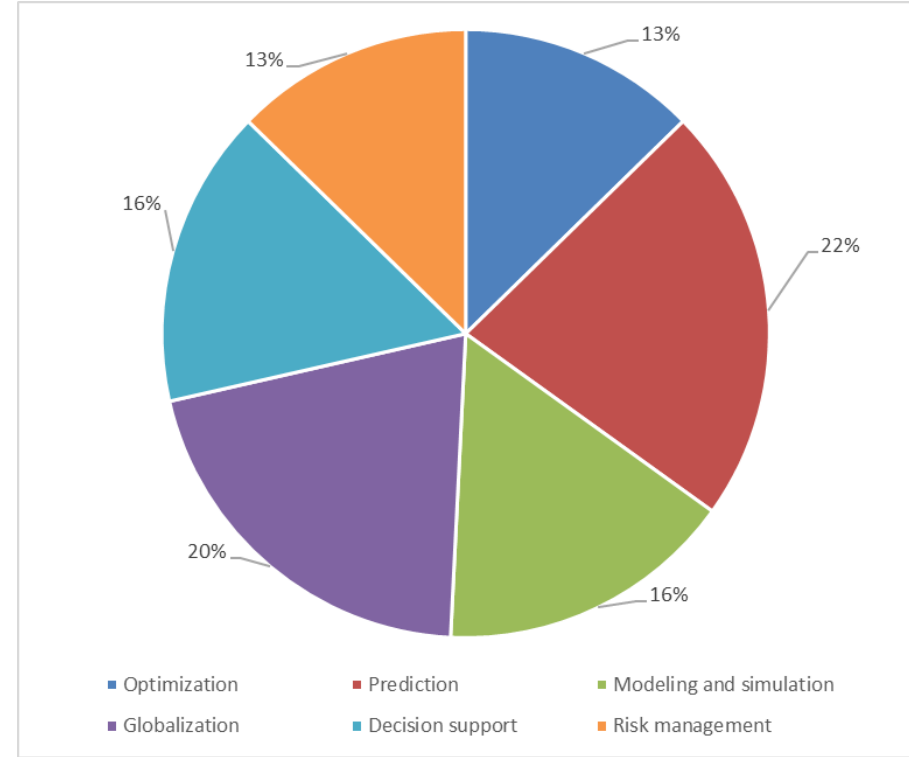
Figure 1. Analysis of the use of neural networks in supply